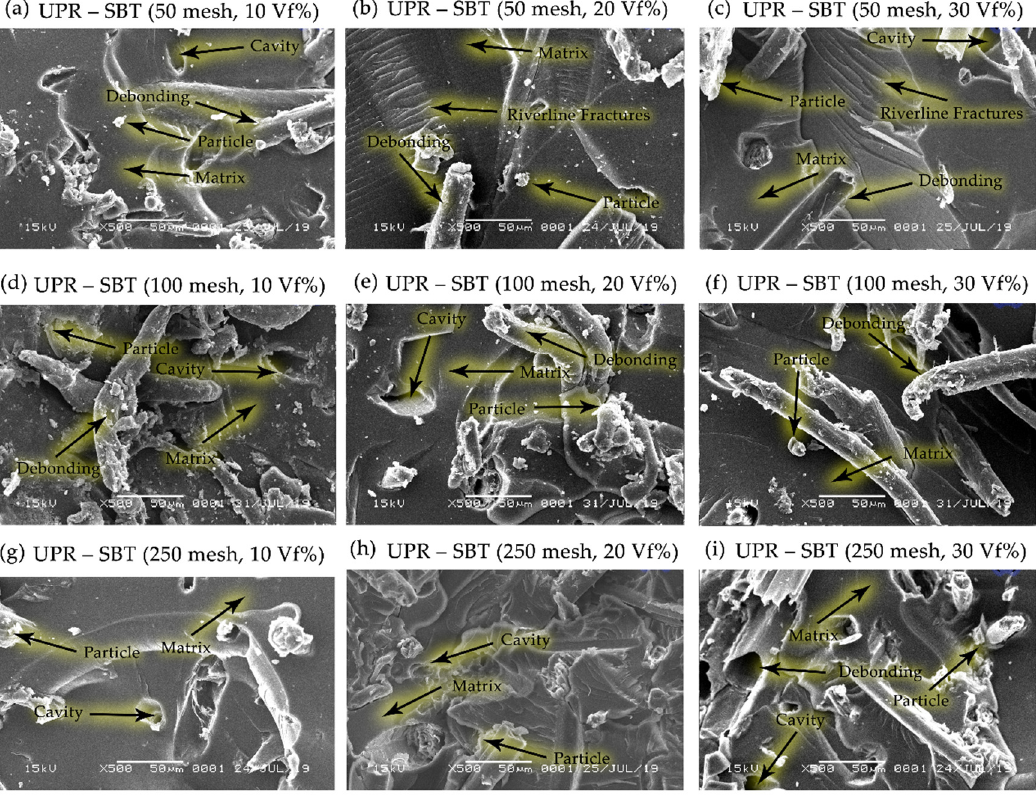
Figure 14. SEM micrographs on the morphology of the UPR–SBT composites.